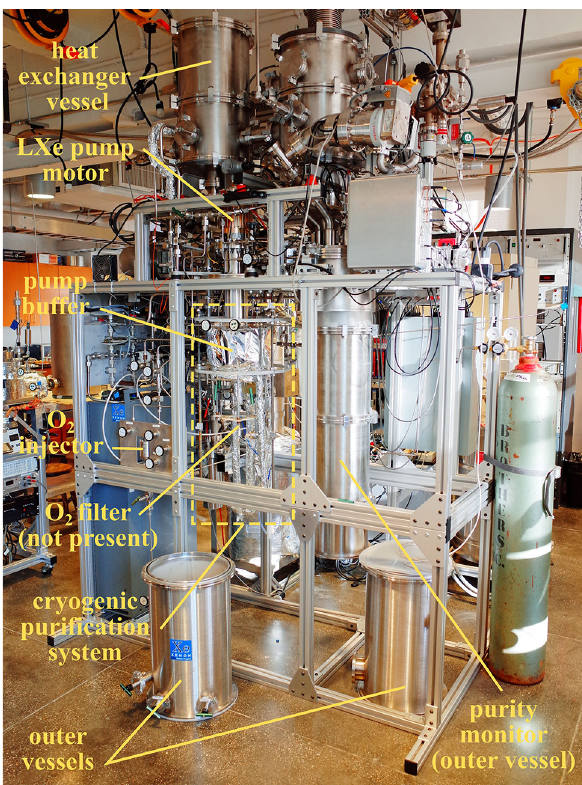
Fig. 1 The Xeclipse apparatus. The closed vessel of the purity monitor is shown on the right, and the exposed cryogenic purification system on the left with its outer vessel